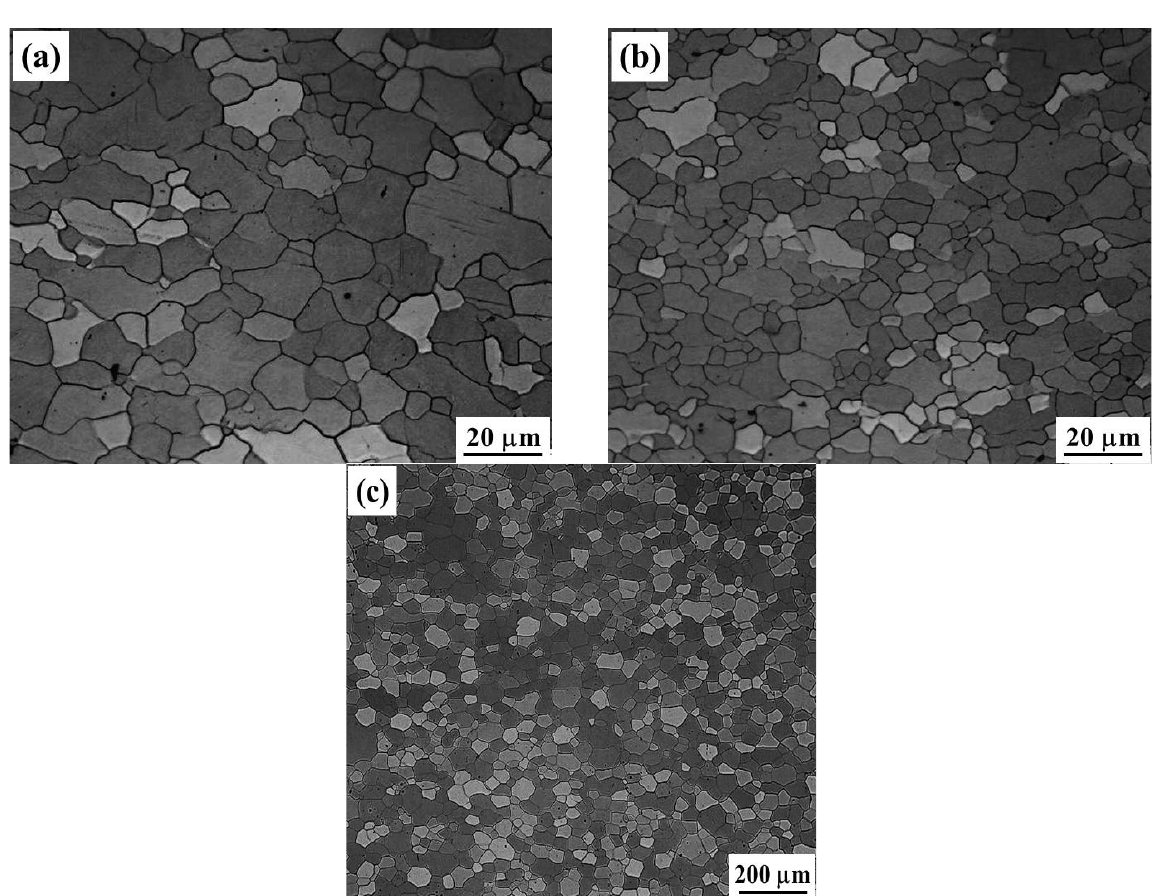
Figure 9. Microstructures of AZ31 alloy extruded at 350 °C and compressed